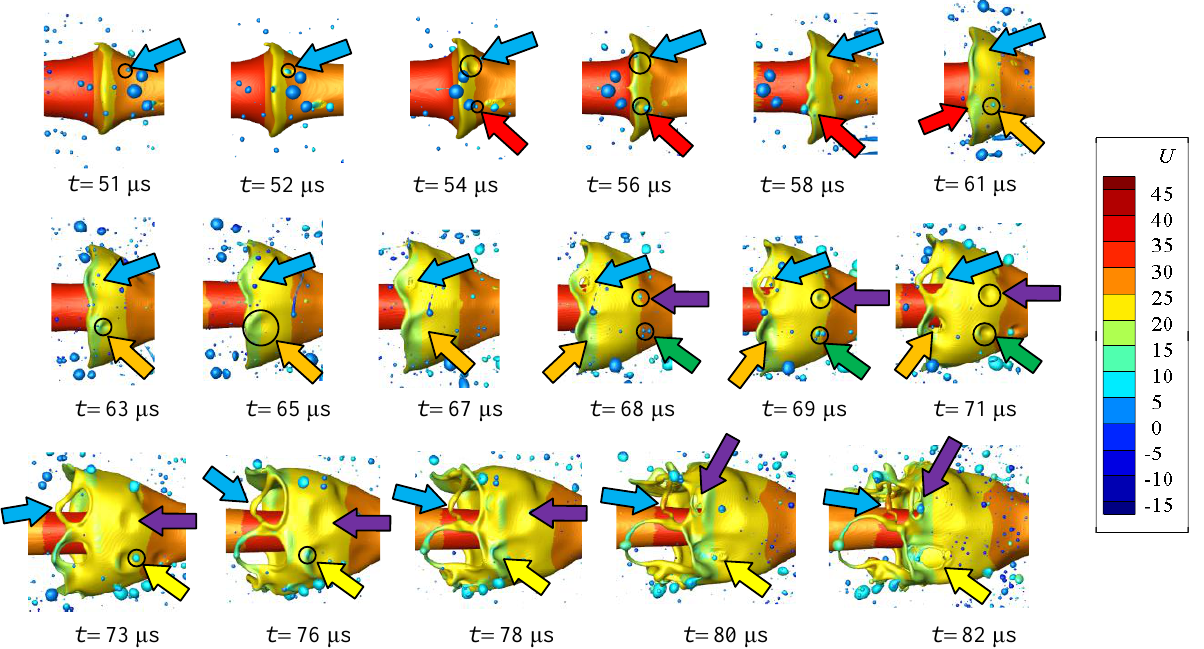
Figure 11. Instability of cone crest closer to jet tip ( f = 66.6 kHz). The color indicates the axial velocity in m/s.